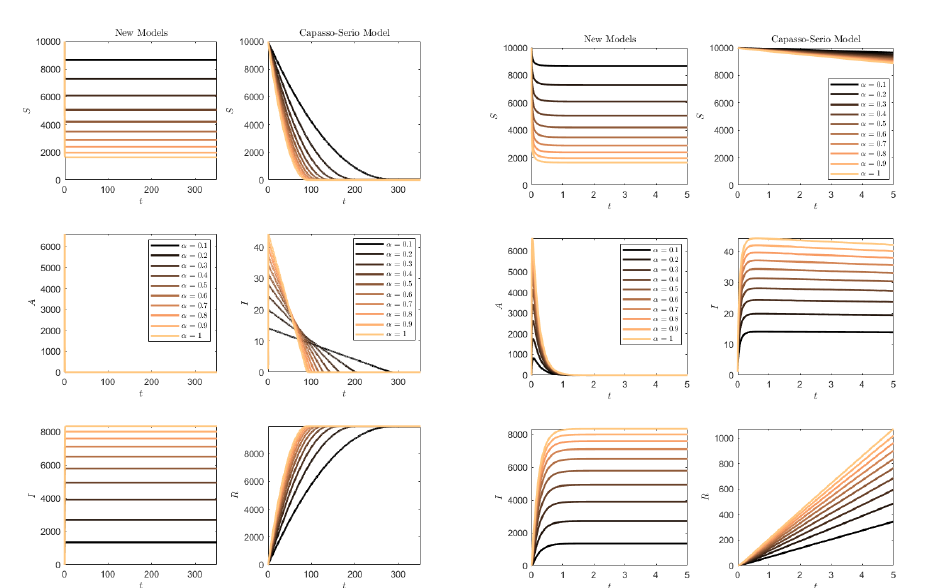
Figure 11. Here, π = γ = 5. Comparison between (1) (or, equivalently, (23)) on the left column, and the Capasso–Serio model (73) on the right column, in terms of the disease transmission rate α ∈ [ 0.1, . . . ,1.0 ] so that, again, it is below the progression to symptomatic or removal rates, α < π = γ with parameter values (74) and initial conditions (50). Left frame: the simulations to show the settling of the systems. Right frame: the blow up of the initial instants to better show the